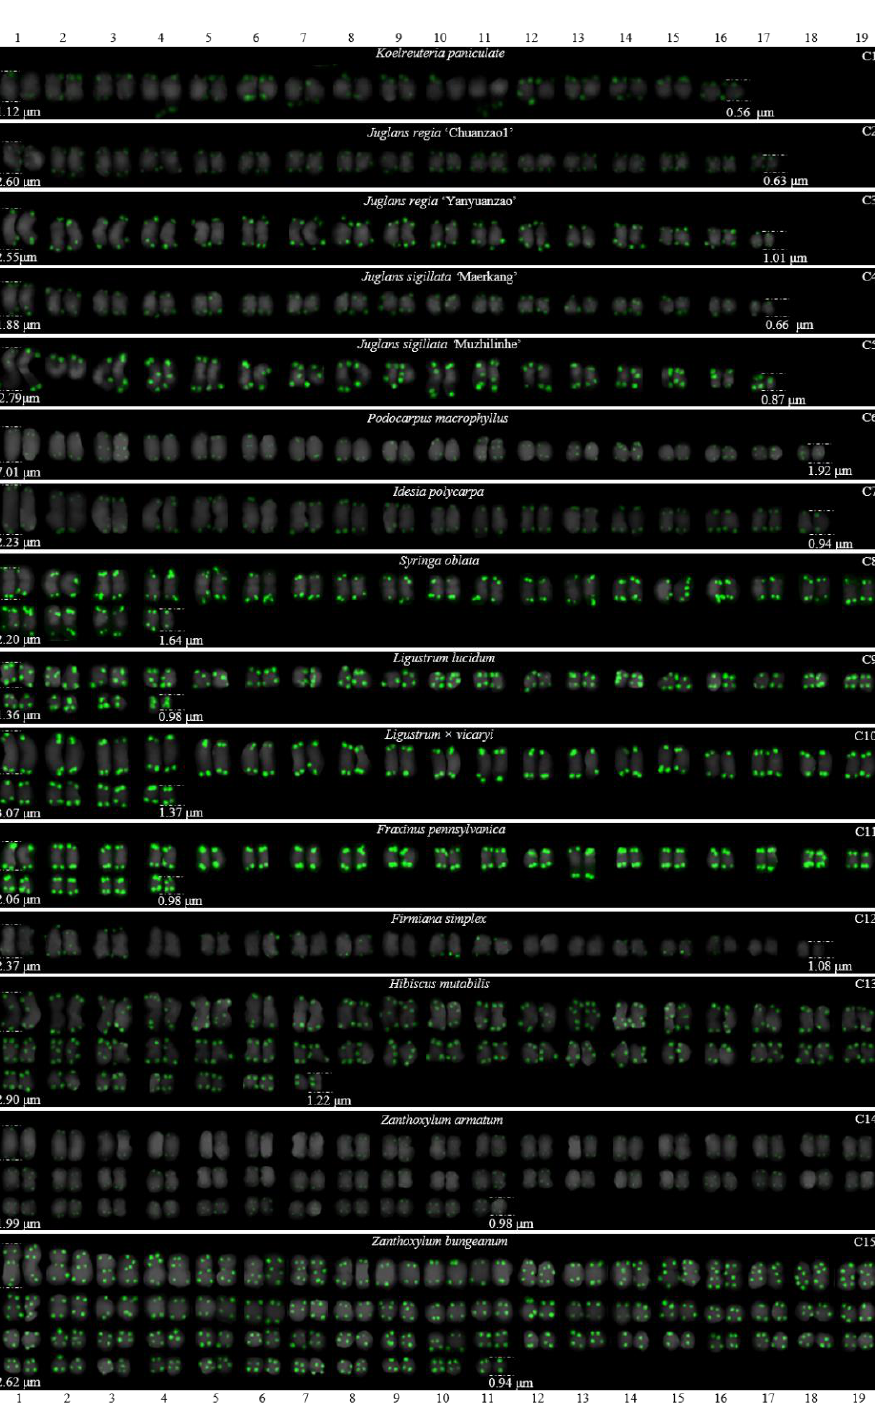
Figure 6. FISH karyogram of 15 woody plants cutting from Figure 3. Oligo-probe (AG 3 T 3 ) 3 is exhibited by green signals. The upper/lower numbers (1 – 19) represent the chromosome pairs. The first/last chromosome of each plant were used to calculate the chromosome length: ( C1 ) K. paniculata